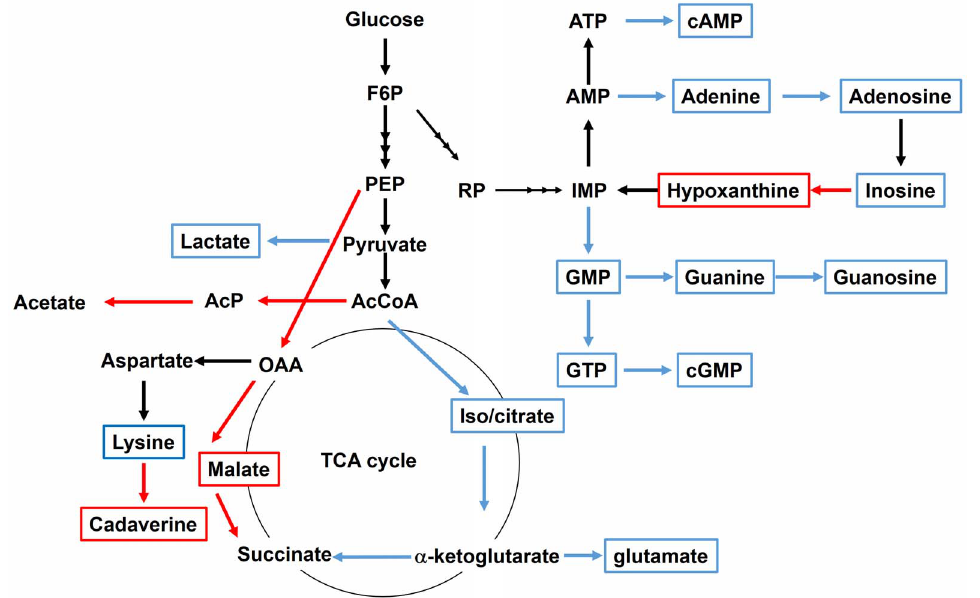
Figure 2. Changes in central metabolism in V.cholerae D nqrA-F mutant. Red solid squares show metabolites that are increased in the D nqrA-F mutant. Blue solid squares show metabolites that are decreased in the D nqrA-F mutant. Red solid arrows show metabolic pathways that are expected to be decreased in the D nqrA-F mutant. Blue solid arrows show metabolic pathways that are expected to be increased in the D nqrA-F mutant. AcP, acetyl phosphate. RP, Ribose phosphate.